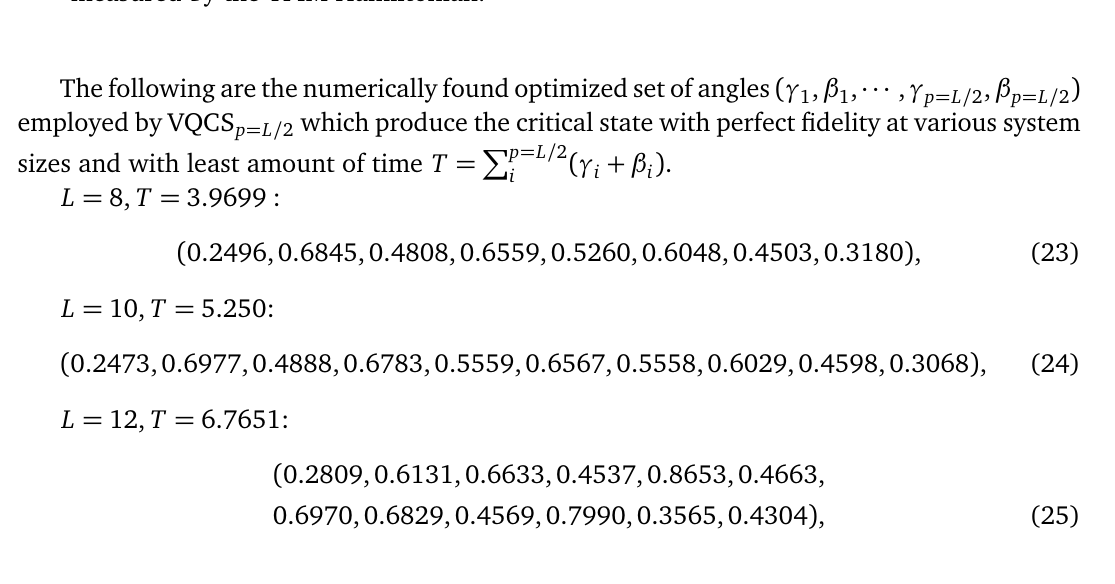
Figure 6: Preparation of critical state. Optimal cost function (22) with energy as measured by the TFIM